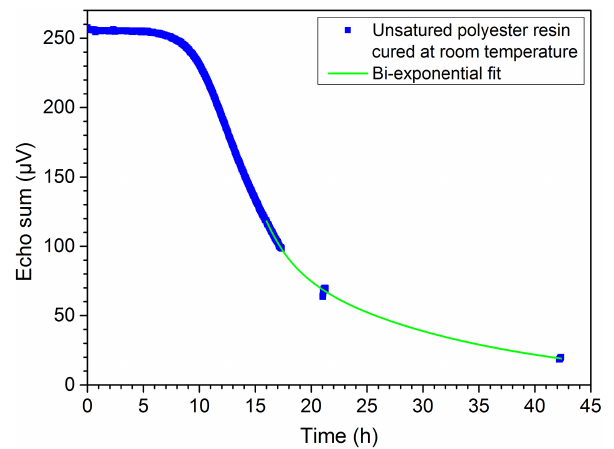
Figure 14. Loss factor of the DEA measurement of the 2C adhesive (DELO-DUOPOX AD840) at 80 ◦ C.